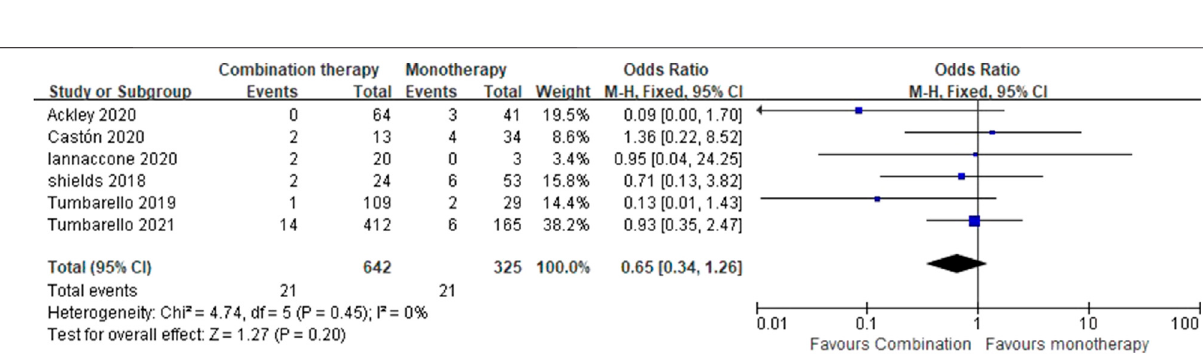
FIGURE 5 | Microbiologically negative of CAZ-AVI therapy alone versus in combination.